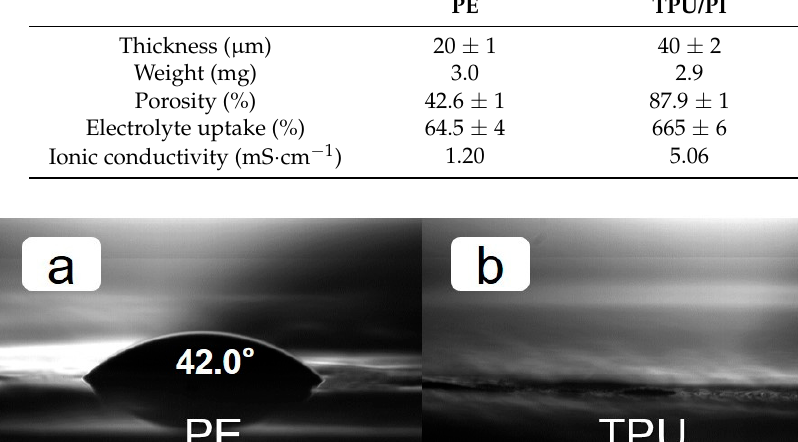
Figure 6. ( a ) EIS of PE and TPU/PI membranes, ( b ) EIS of batteries assembled with PE and TPU/PI membranes. Electrochemical stability is a key property for polymer electrolytes vis a vis their practical use in lithium-ion batteries. A linear sweep voltammograms (LSV) experiment in potential range of 0–7.0 V